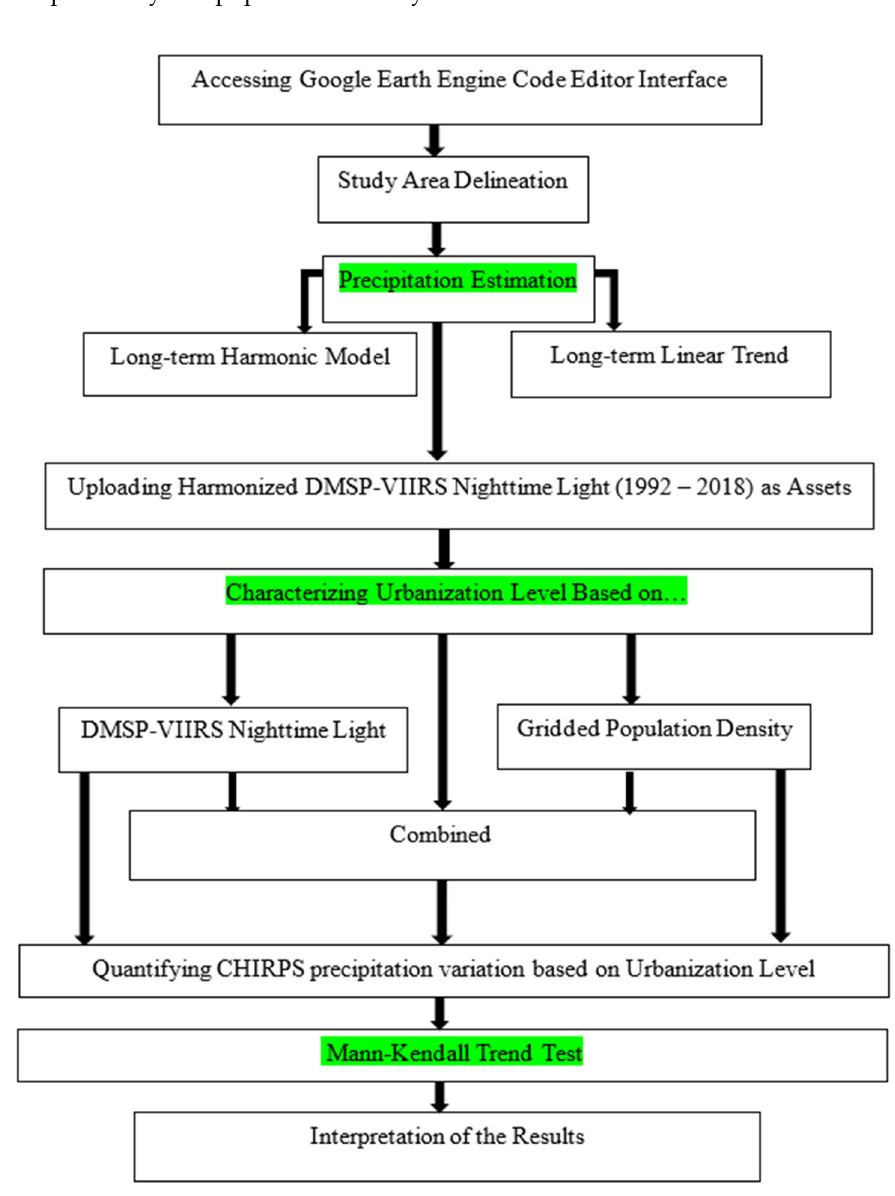
Figure 2. Workflow for the analysis of spatio-temporal responses of precipitation to urbanization with Google Earth Engine. This workflow illustrated how the research will be conducted by following specific sequential steps. The green-colored boxes refer to the three major steps of this research work.